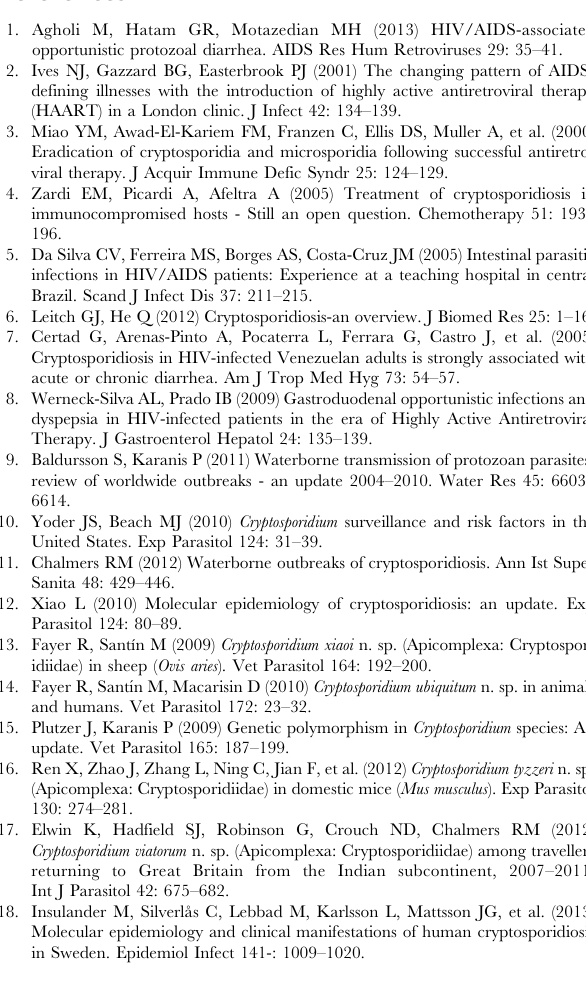
Table S1 Association between CD4 + cell count and infection with Cryptosporidium species or C. parvum and C. hominis subtypes in HIV/AIDS patients in Ethiopia*. Table S2 Association between HAART history and infection with Cryptosporidium species or C. parvum and C. hominis subtypes in HIV/AIDS patients in